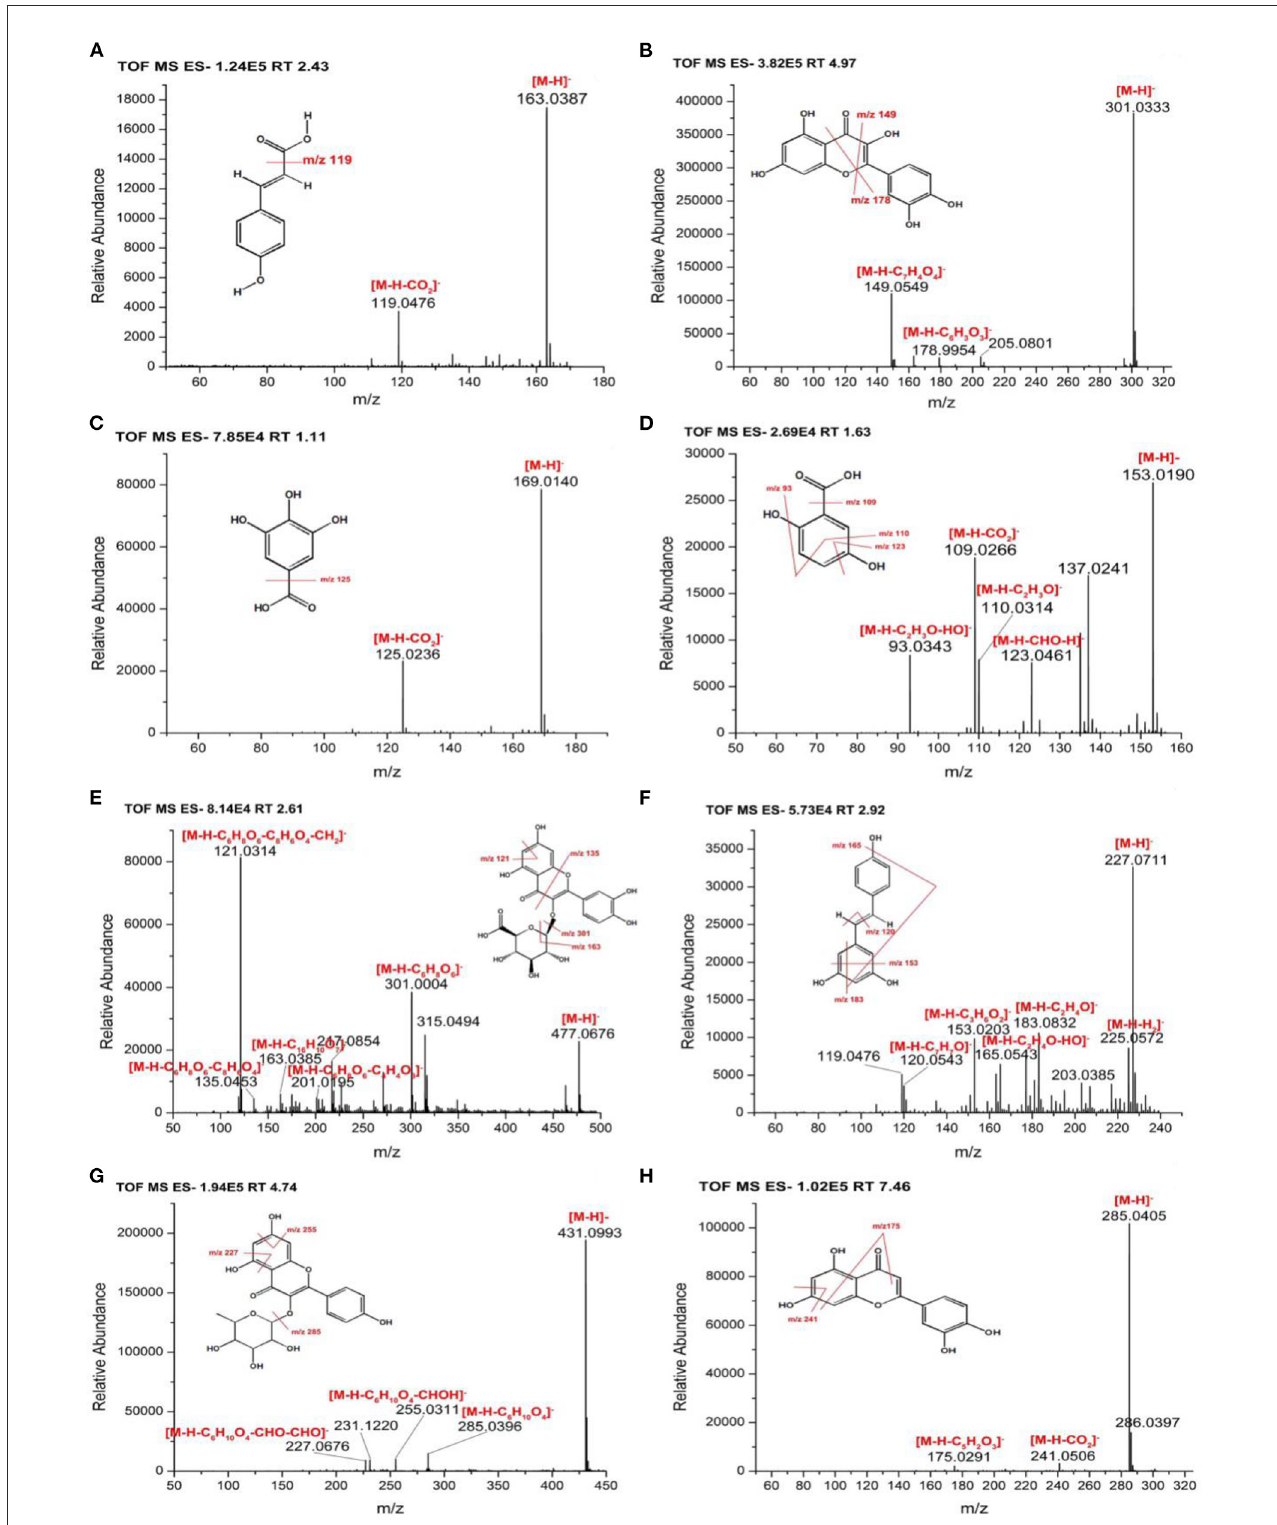
FIGURE2 MS/MS spectra and fragmentation patterns of selected phenolic compounds (A) p-coumaric acid, (B) quercetin, (C) gallic acid, (D) 2, 5-dihydroxybenzoic acid, (E) quercetin-3- O -beta-D-glucuronide, (F) resveratrol, (G) kaempferol-3- O -rhamnoside, and (H)